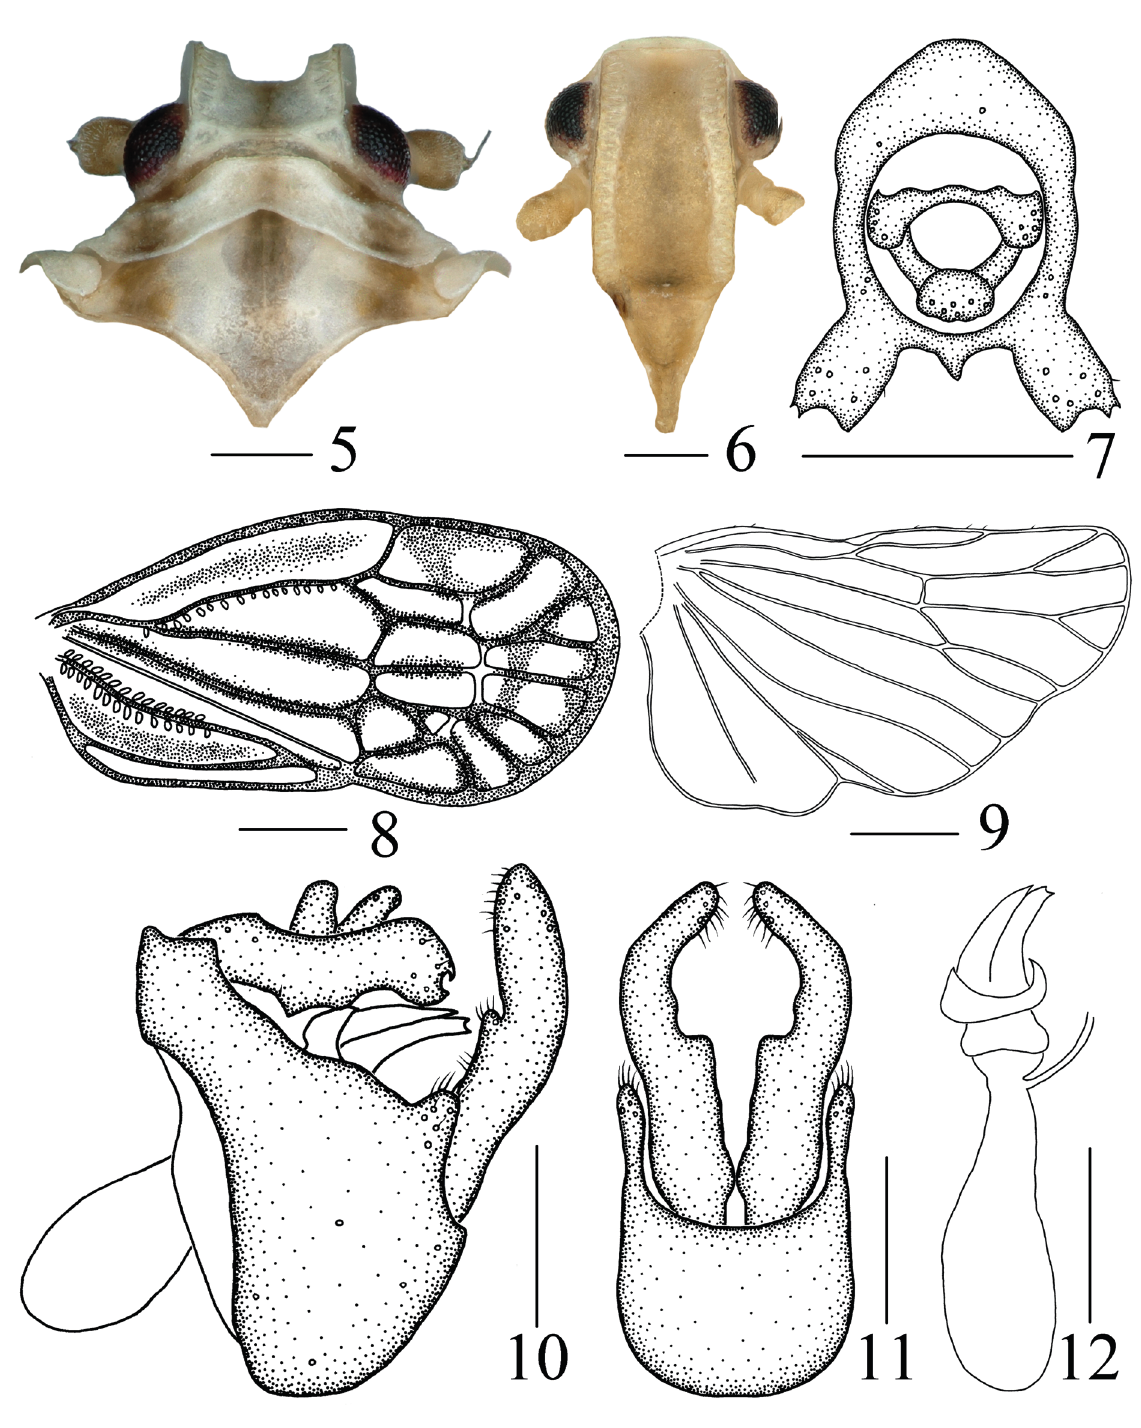
Figs 5–12. Eponisiella dafangensis sp. nov., ♂ , holotype (IEGU). 5 . Head and thorax, dorsal view. 6 . Frons, ventral view. 7 . Anal tube, dorsal view. 8 . Tegmina. 9 . Wing. 10 . Pygofer, lateral view. 11 . Gonostyli and pygofer, caudoventral view. 12 . Aedeagus, left lateral view. Scale bars: 5–7, 10– 12 = 0.2 mm; 8–9 = 0.5